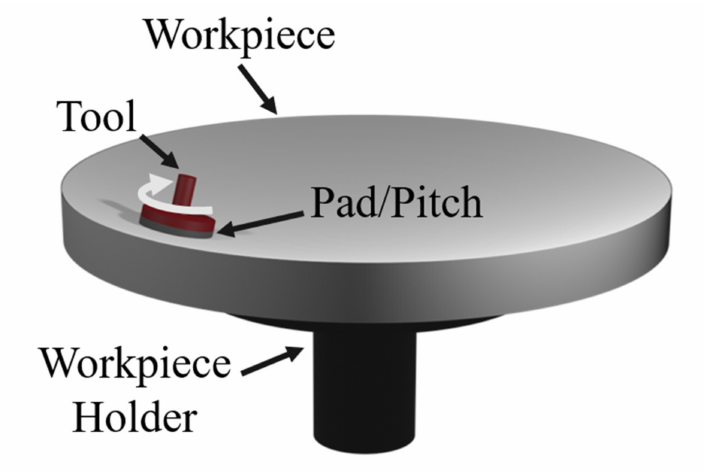
Figure 2. Setup for fabrication of optic via SATP. The tool is rotated at high speeds and translated to traverse the workpiece. The pad and/or pitch with polishing compound abrasively remove material from the workpiece surface.